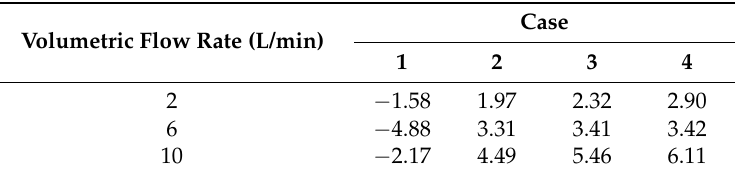
Figure 16. Effect of volumetric flow rate and division plates on Efficiency Deterioration Factor of solar collector. Table 8. Efficiency improvement